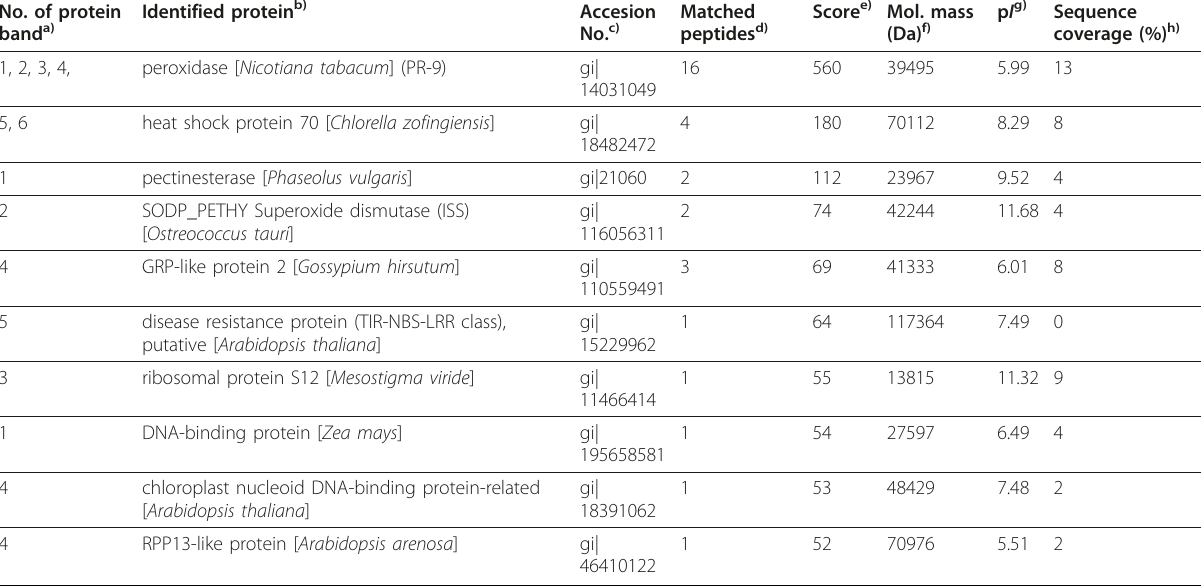
Table 2 Defense-related proteins identified in fractions after purification of nucleases from extracts of Corydalis cava tubers using